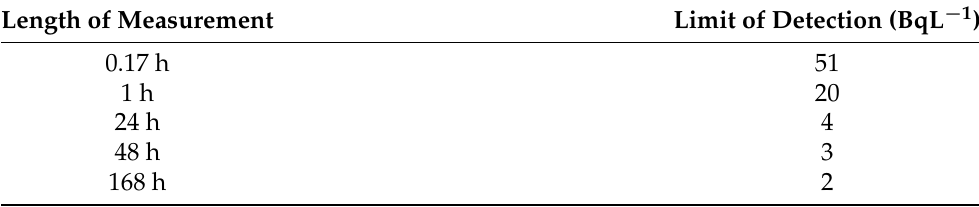
Table 6. The limit of measurement for 90 Sr in the flexible CdTe detector for increasing lengths of